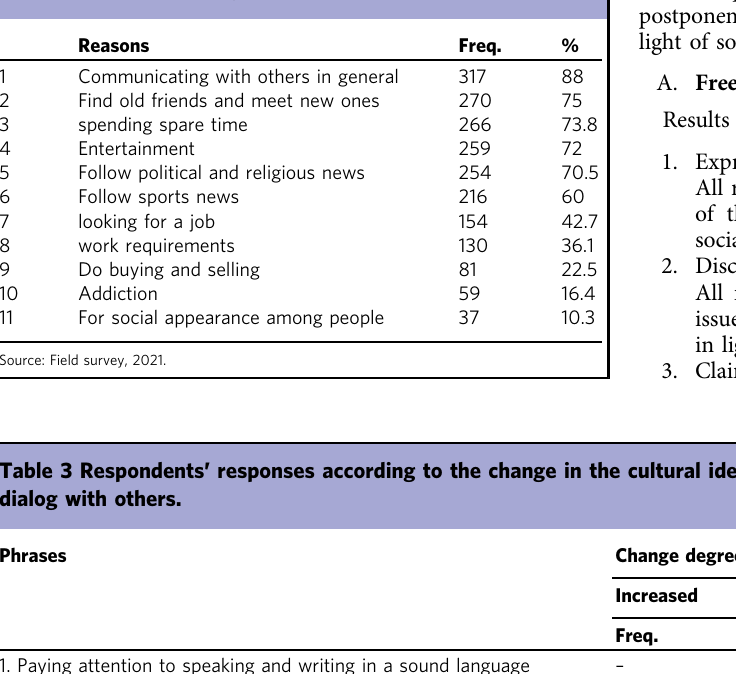
Table 2 Reasons for respondents ’ use of social media.